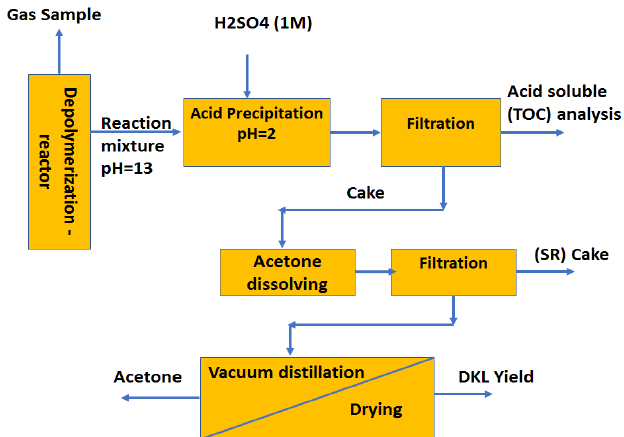
Figure 1. Work-up procedure for products separation following the depolymerization of lignin in black liquor.